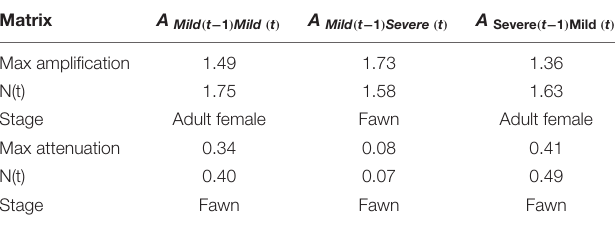
TABLE 4 | Maximum possible amplifications and attenuations of Sitka black-tailed deer population projection matrices observed during this study (2010–2013), along with number achieved at max/min [N(t)], and stage making the greatest contribution.